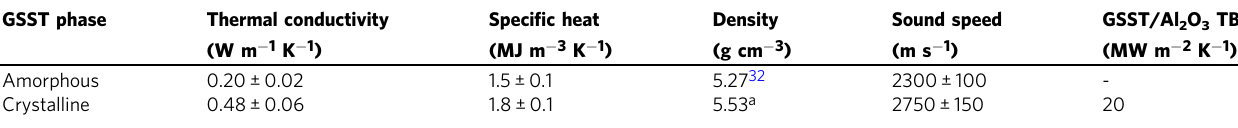
Table 1 The thermal properties of GSST studied here in amorphous and crystalline phases for 150 nm GSST.